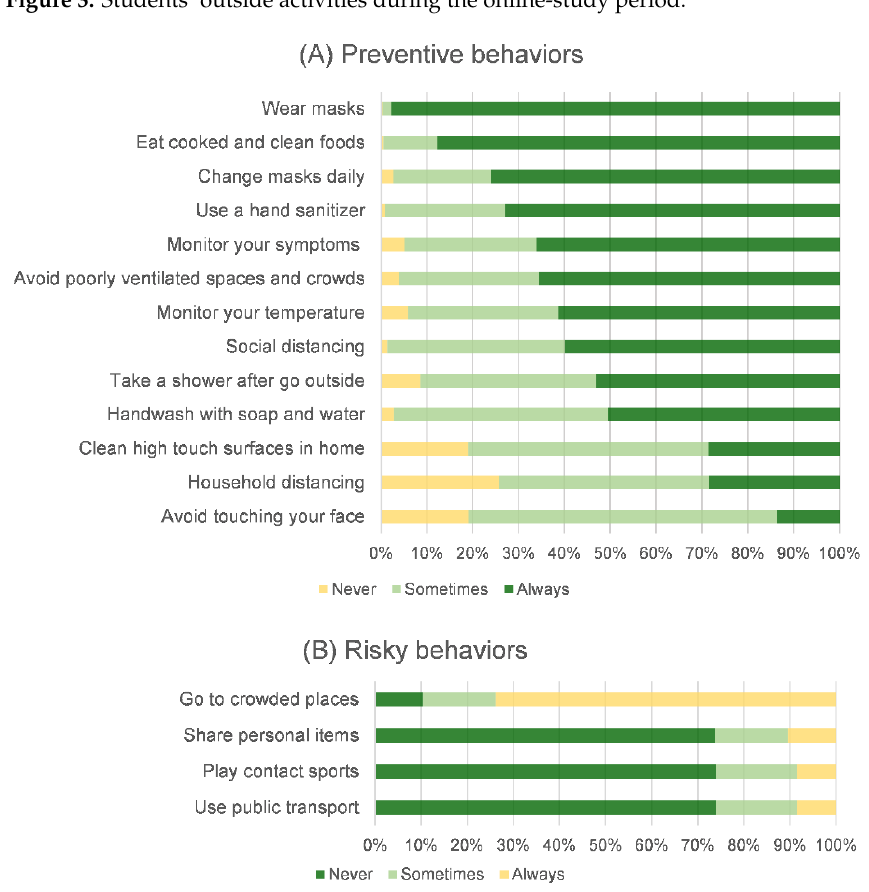
Figure 4. Preventive and risky behaviors of students.